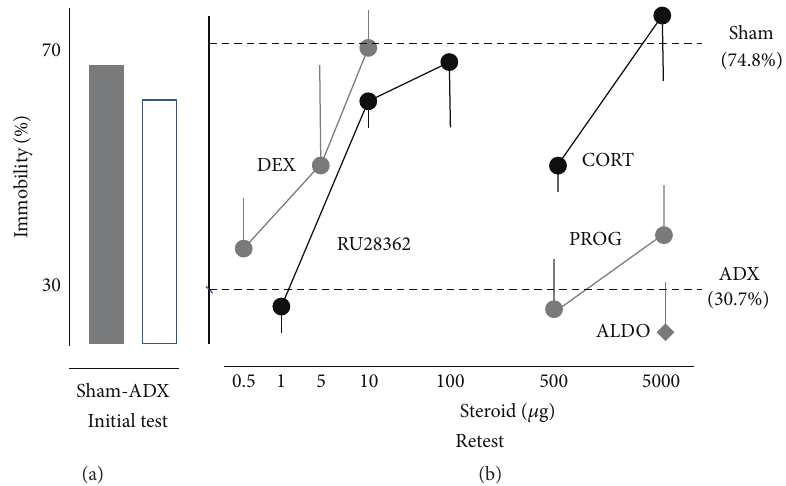
Figure 2: (a) Left panel shows % immobility during the last 5 min of the 15 min initial test of SHAM and adrenalectomised (ADX) animals. (b) Right panel shows the effects of various steroids, given 15 min after the initial swimming exposure, on retention of acquired immobility of ADX rats during the 5 minutes retest period. Data are expressed as mean ± the standard error of the mean as % immobility time. Dashed lines represent the % immobility of SHAM (74,8%) and ADX (30,7%) rats. Fifty ADX and 33 sham rats were used in these experiments. Six animals wereusedperdifferentdosagesofdexamethasone,cortisol,RU38362,andprogesterone.PosthoccomparisonsfollowingasignificantANOVA revealed that the groups treated with DEX (5 and 10 𝜇 g), RU28362 (10 and 100 𝜇 g), and cortisol (500 and 5000 𝜇 g) differed significantly from ADX but not from sham rats. For more information on these data we refer to [11].